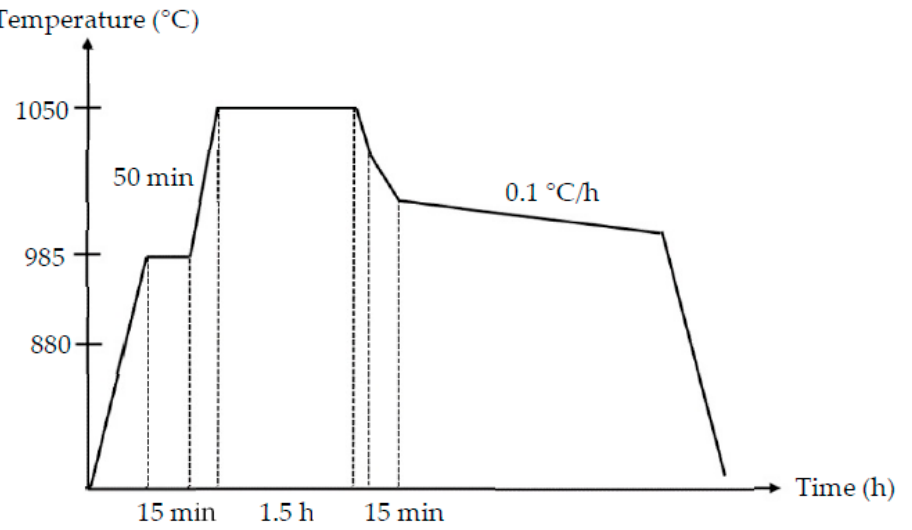
Figure 2. Time–temperature profile for Y123 bulk fabricated by TSIG process.